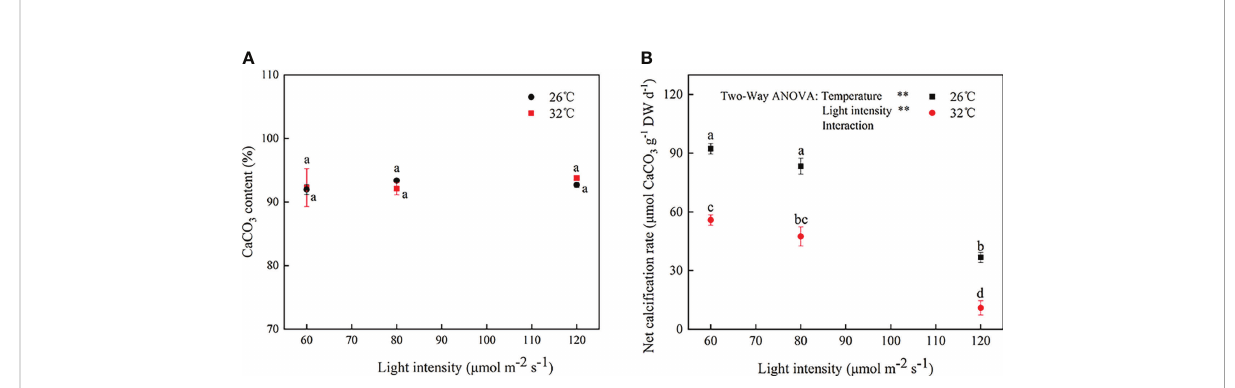
FIGURE 4 The (A) CaCO 3 content and (B) net calci fi cation rate in A cf. fragilissima after 4-week cultivation period under different conditions. Error bars correspond to the standard deviation with three independent replicates. abcd , Different letters implied signi fi cant differences ( P < 0.05) for each parameter. **P < 0.01.